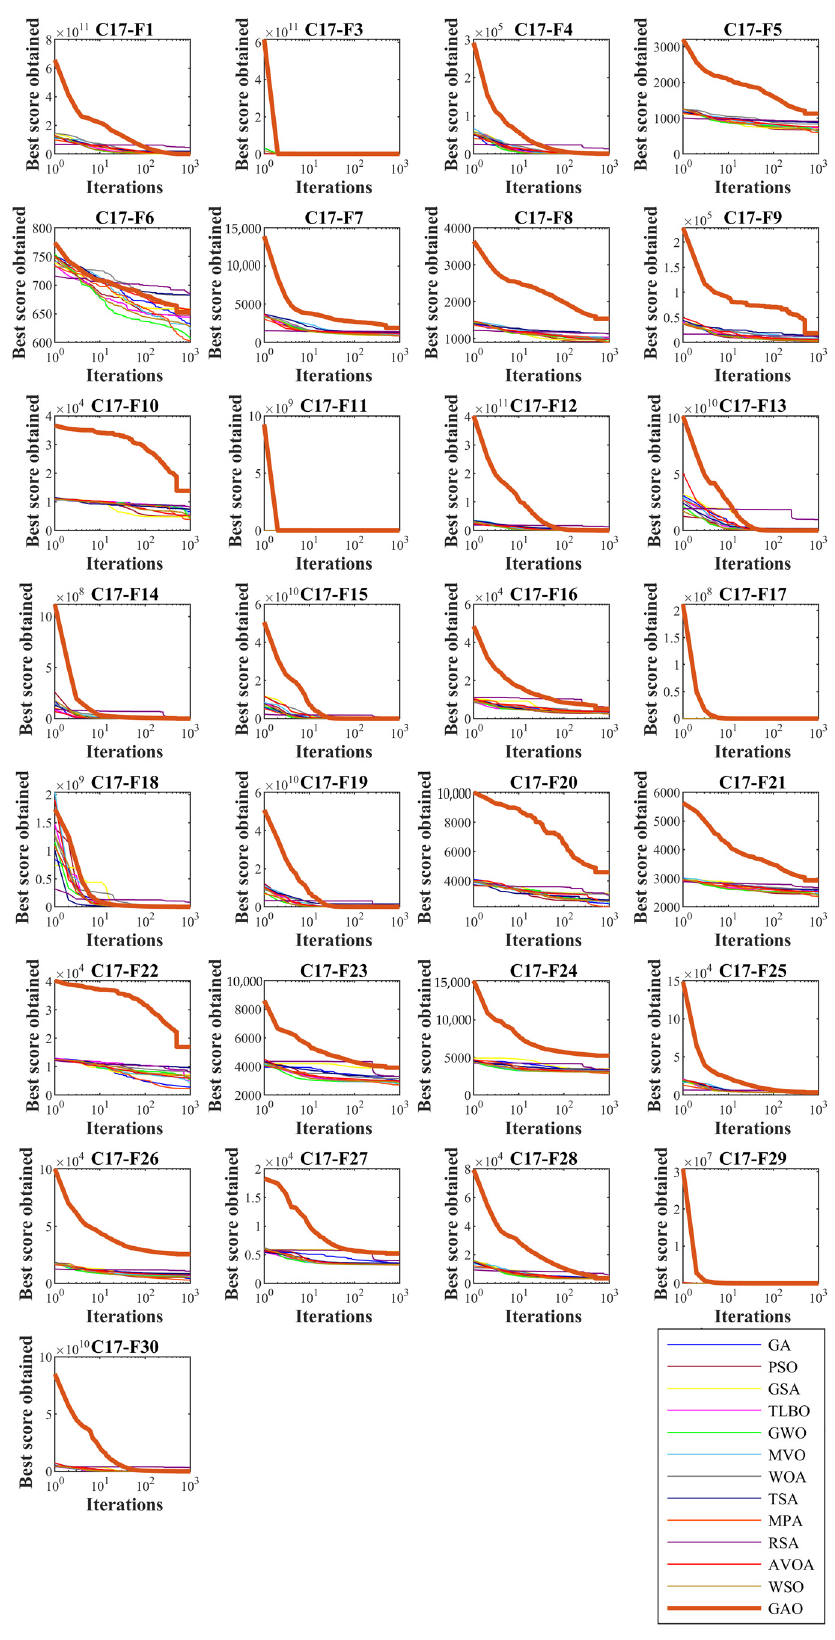
Figure 6. Convergence curves of GAO and competitor algorithms performance on CEC 2017 test suite (dimension 𝑚 = 100 ).